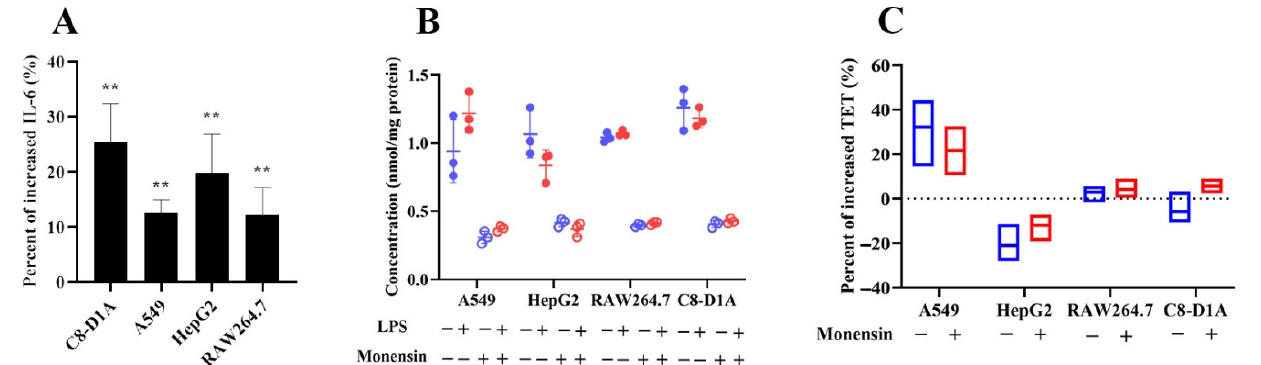
Figure 5. The uptake of TET in normal and LPS-induced cells in the presence or absence of monensin. ( A ) The increased levels of IL-6 after being induced by LPS. ( B ) The uptake of TET in four kinds of